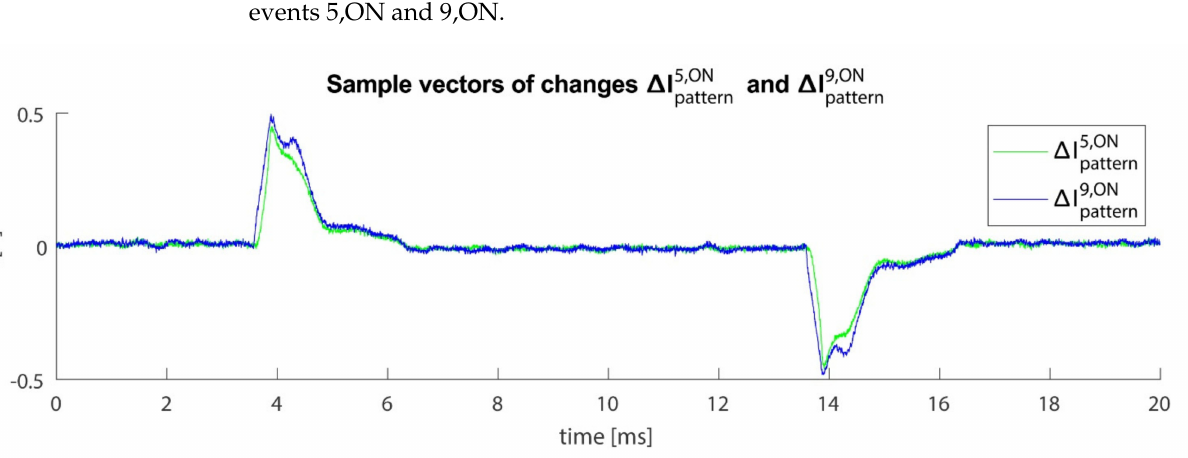
Figure 11. Comparison of sample vectors of changes for appliance of categories 5,ON and